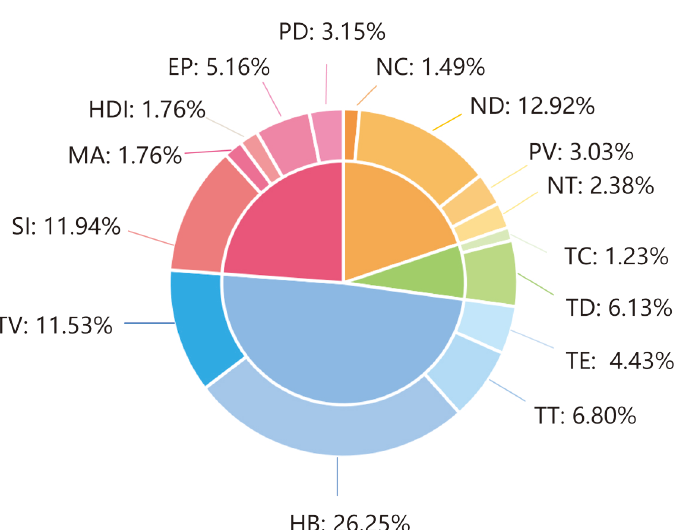
Figure 4. The weight of the major factors and secondary indicators determined by the AHP